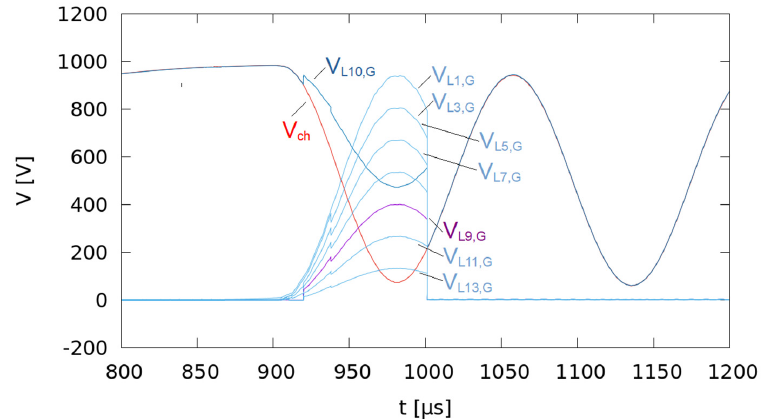
Figure 4. Simulated voltages at nodes in the positive charging path of the current-compensated chokes versus ground (V L1,G , V L3,G … V L13,G ), and the voltage of the ground-side connection of the power supply (V L10,G ). Thereby, the nodes are named according to the respective coil of the current- compensated choke on the right-hand side seen from the node. V Ch marks the simulated charging voltage at the input terminal for charging the Marx generator according to the schematic in Figure 3. (R D : open circuit).